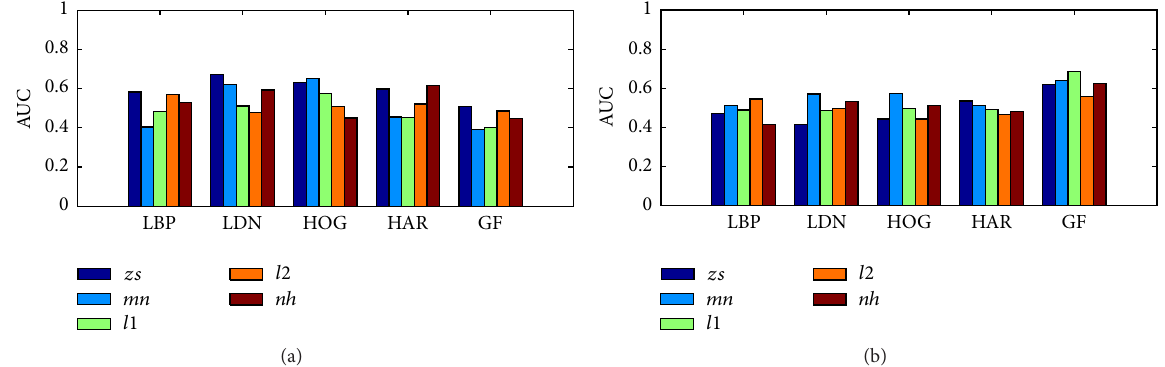
Figure 5: The performance of the texture analysis methods with different feature normalization methods using (a) the LSVM and (b) the